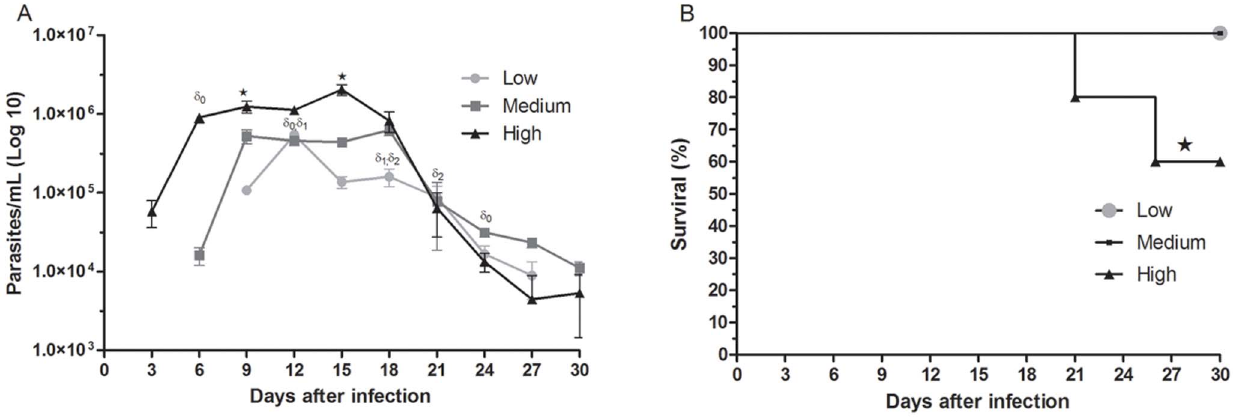
Figure 1. Parasitemia and survival of mice in the acute stage of T.cruzi infection. C57BL/6 mice were challenged with 3 6 10 2 (low dose), 3 6 10 3 (medium dose) or 3 6 10 4 (high dose) blood trypomastigotes. Parasitemia (A) was determined by counting the number of parasites in 5 m L of blood collected from tail snips at the indicated time points. Each point represents the mean of individual values from 10 mice. In the survival curve (B), 10 animals were individually monitored for 30 days of infection. d 0 p # 0.05 indicates a significant difference when the mice infected with medium- inoculum were compared to the mice infected with high inoculum, d 1 p # 0.05 indicates a significant difference when the mice from the low-inoculum group were compared to the mice from the high-inoculum group, d 2 p # 0.05 indicates a significant difference when mice from the low-inoculum group were compared to mice from the medium-inoculum group, and *p # 0.05 indicates a significant difference when animals from the infected groups were compared to the uninfected control